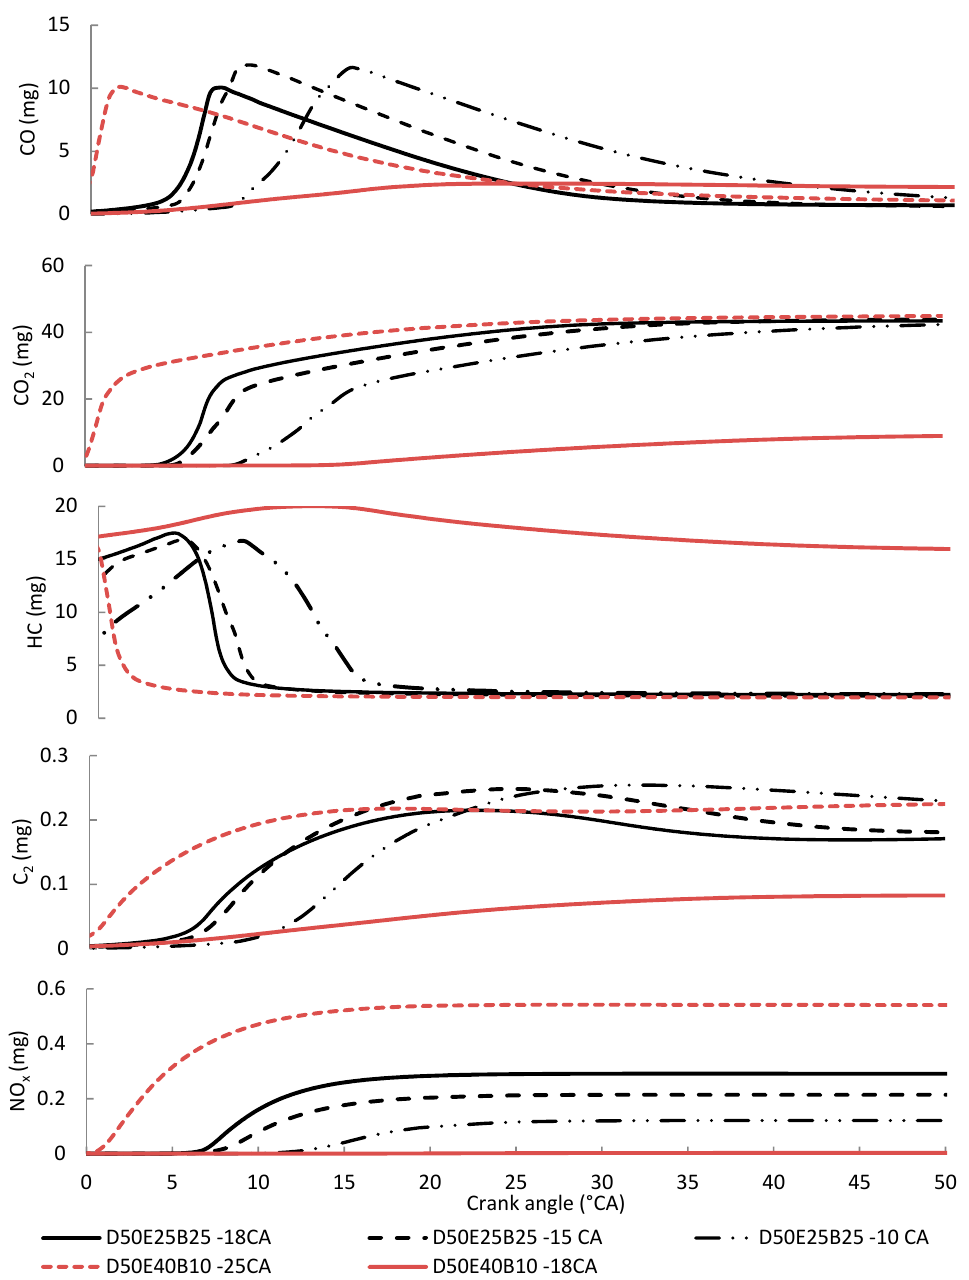
Figure 12. Emission graphs of D50E25B25 blends running by using different injection timing at 1600 RPM.